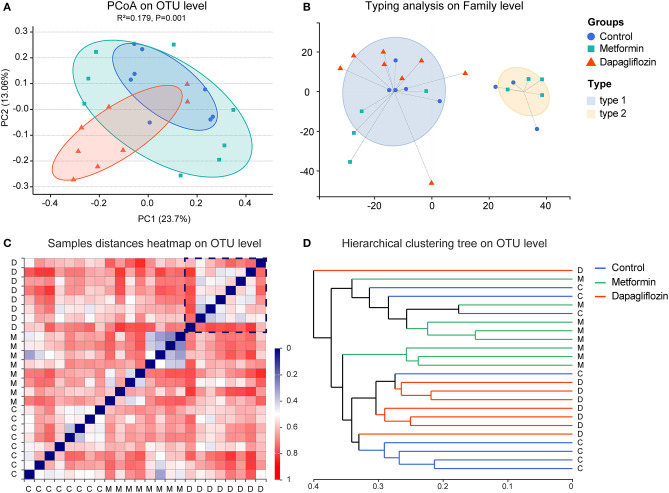
Beta diversity and enterotypes analysis in three groups. (A) Principal coordinates analysis (PCoA). The two principal coordinates (PC1-PC2) explain 23.7 and 13.06%, respectively, and the analysis of permutational multivariate analysis of variance (pANOVA) was p = 0.001. (B) Clustering of all 24 samples into two enterotypes on the family level. Type1 was presented by Ruminococcaceae and type 2 was Muribaculaceae. (C) Samples distance heatmap on operational taxonomic units (OTU) level. Clustering of samples based on Bray-Curtis distances. Each row or column represents one sample. (D) Hierarchical clustering tree on OTU level. One straight line represents on sample. C, control group; M, metformin group; D, dapagliflozin group.